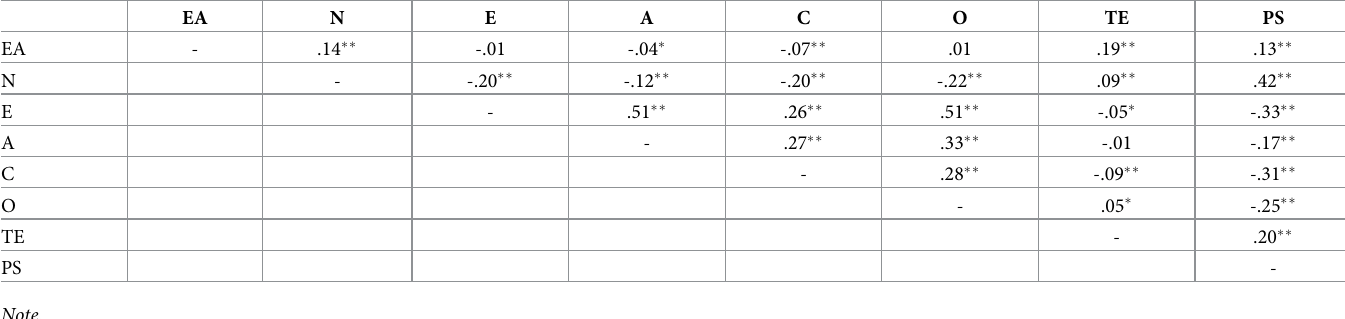
Table 2. Correlations among manifest variables in the MIDUS